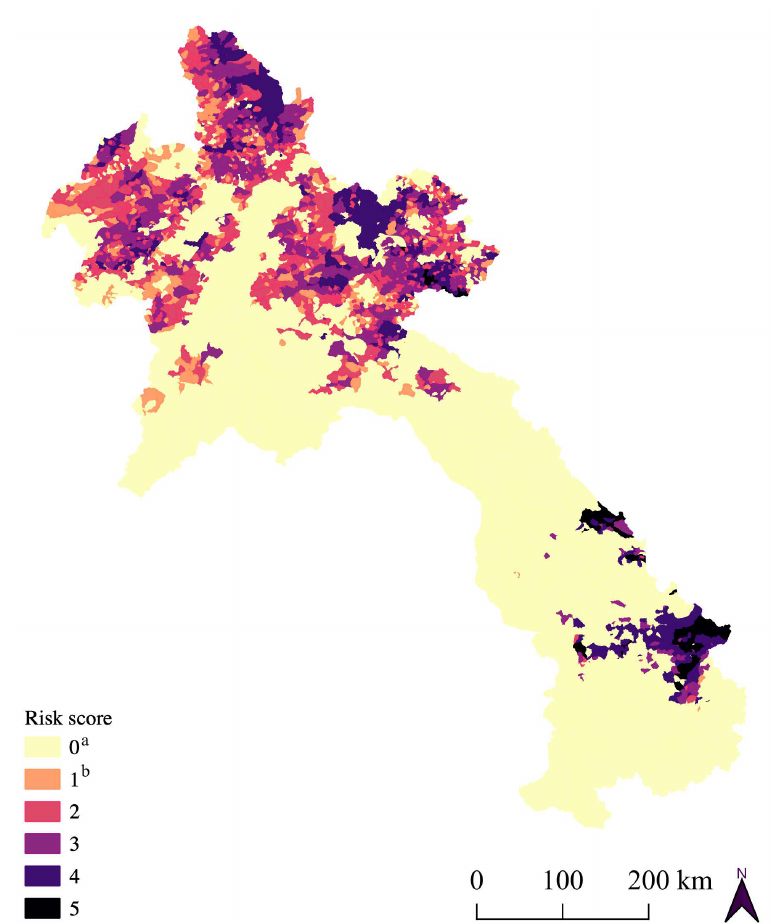
Figure 2. Mapping of local autocorrelation statistics. a Not a pig hot spot. b Pig hot spot